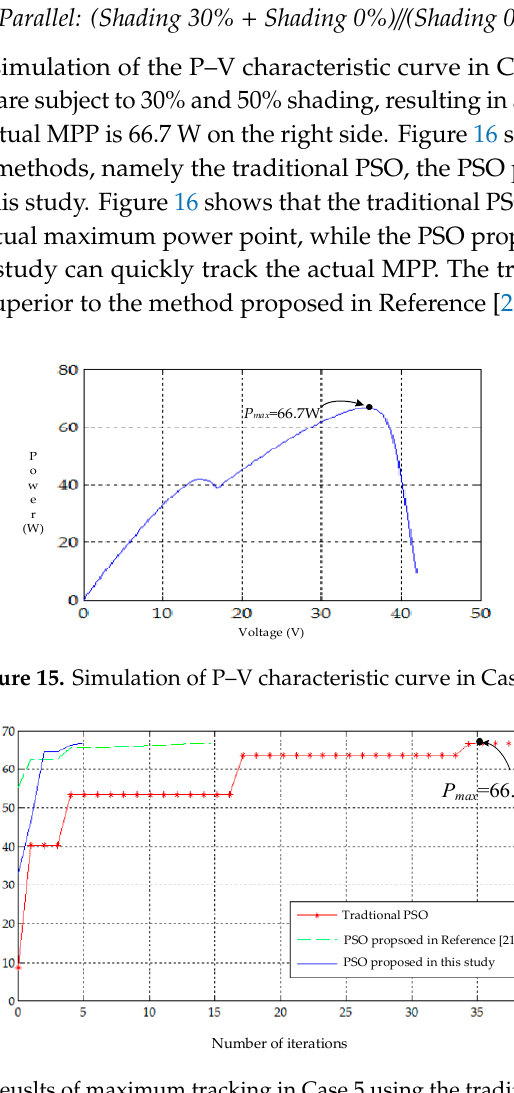
Figure 14. Comaprison resutls of maximum power tracking in Case 4 using the traditional PSO, the PSO in Reference [21], and the PSO proposed in this study.